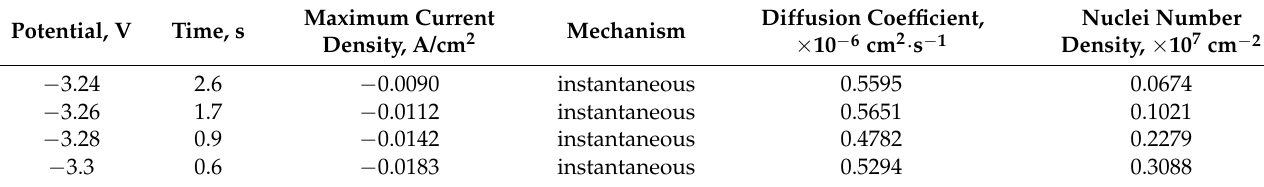
Table 1. Summarized parameters from Hills–Scharifker theoretical analysis of the chronoamperome- try